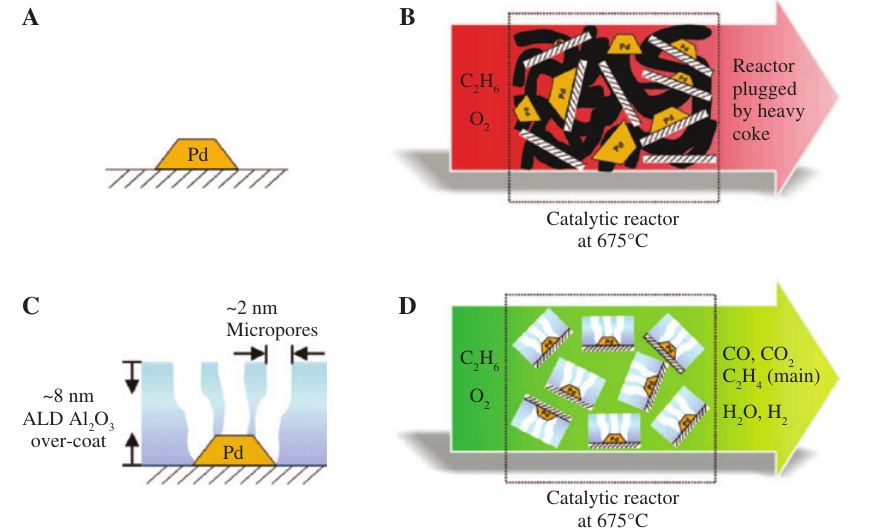
O catalysts with and without an ALD Al 2 3 O catalyst. (B) The uncoated Pd/ Al 2 3 O -overcoated Pd/Al 2 3